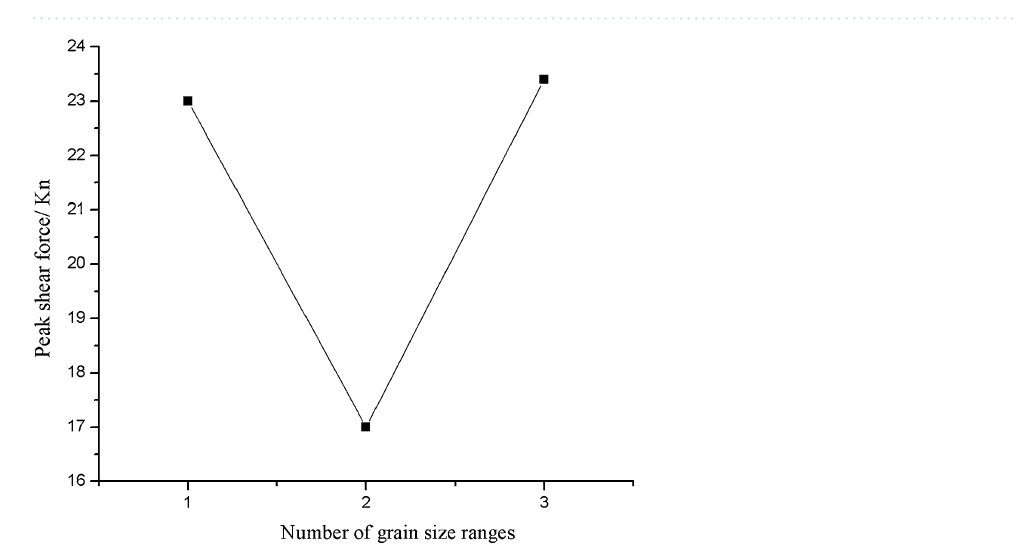
Figure 47. Shear force–shear displacement curve for a specimen containing 0–2.56 mm sand particles (produced from three grain size ranges).